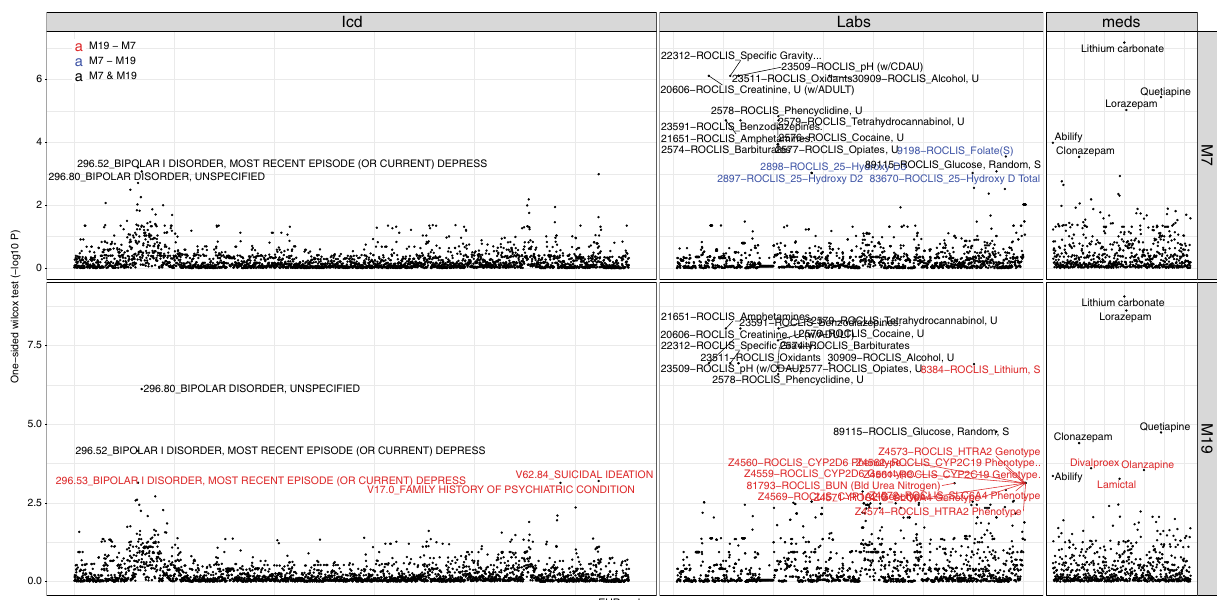
Fig. 5 Phenome-wide association studies (PheWAS) of the 6776 EHR codes on the two bipolar disorder mixture topics (M7 and M19) based on the Mayo Clinic dataset. For each EHR code, we tested the difference between patient groups with and without that code in terms of M19 and M7 topic membership probabilities. The labeled EHR codes are the ones with Wilcoxon signed-rank one-sided test p -values < 0.001. The red, blue, and black color indicate the codes that are signi fi cant in only M19, in only M7, and in both M19 and M7, respectively. PheWAS for the PPI questions are displayed in Supplementary Fig.